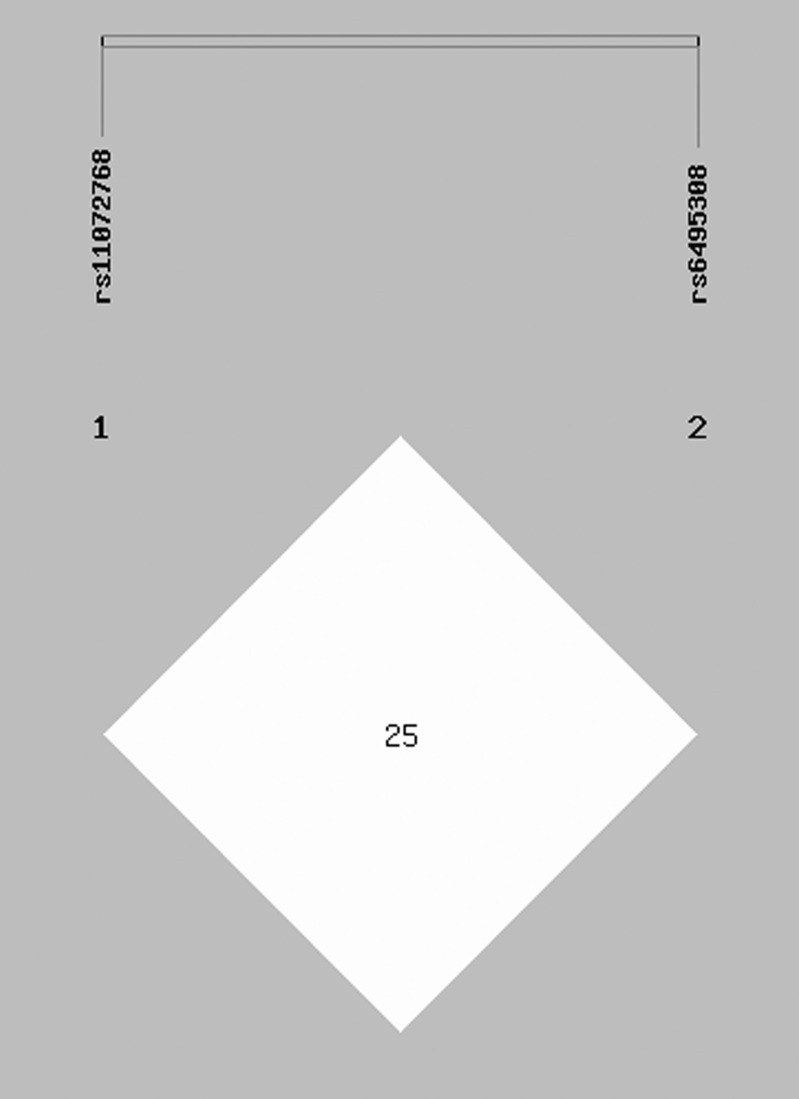
Linkage disequilibrium (LD) patterns of the two SNPs in 15q25.1.Numbers inside the boxes represent r2 values for LD. Colors indicate the strength of LD between pair-wise combinations of SNPs (white, low LD; red, high LD).